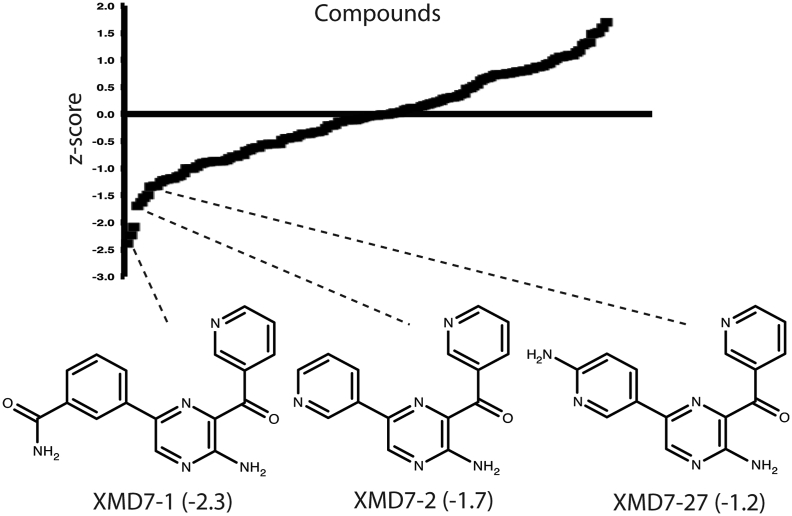
Compounds assigned z-scores. Plot of z-scores where each data point represents a single compound. A list of each compound with its assigned z-scores is shown in Supplementary Table S3. The structures and z-scores (stated in parentheses) of XMD7-1, -2 and -27 are identified.